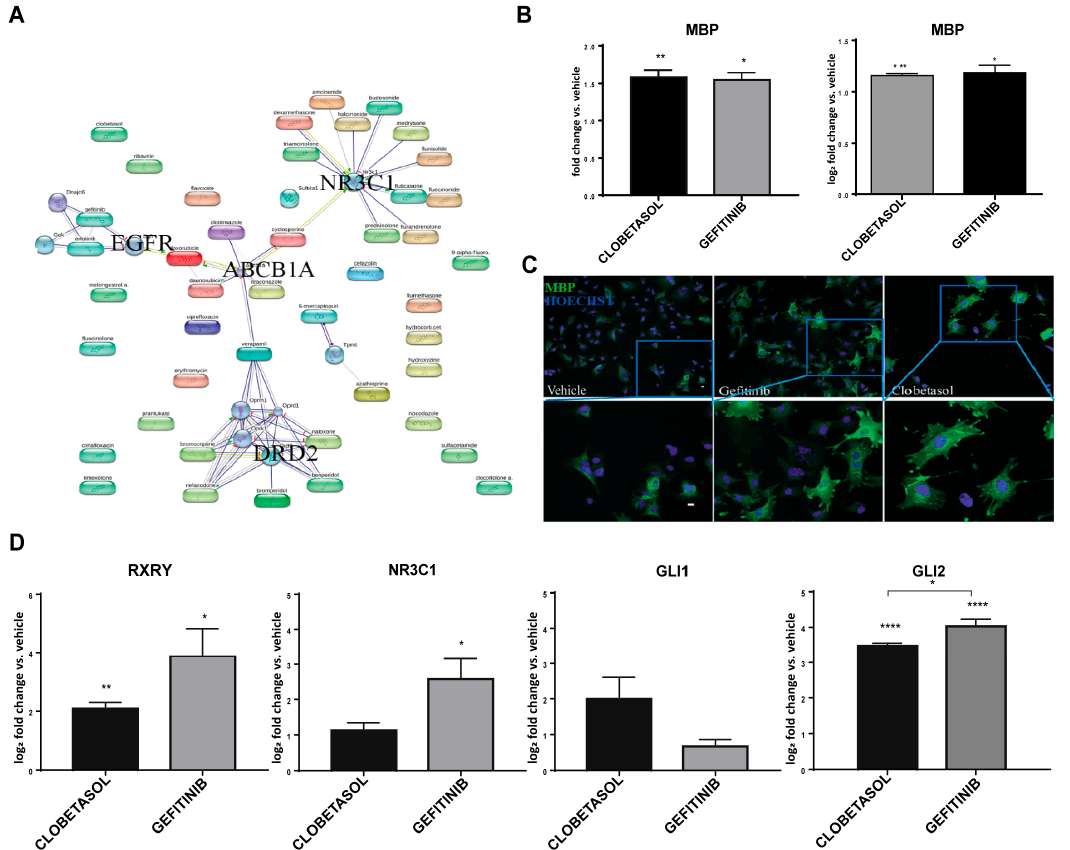
Figure 1. Gefitinib and Clobetasol stimulate MBP, RXR γ and Gli2 expression and Oli-neuM differentiation ( A ) STITCH Confidence view. Chemical-network analysis of drugs promoting MBP expression in OPC cell lines. Thicker lines indicate stronger associations; grey lines: protein-protein interactions. Green: chemical-protein interactions; red: interactions between chemicals. See Table S1 for chemical list and details. ( B ) MBP expression analysis of Oli-neuM treated for 48 h with 5 μ M Clobetasol or 1 μ M Gefitinib. Left panel: immunofluorescence quantitative analysis; Right panel: qPCR expression analyses. Data were normalized to vehicle, and are expressed as mean ± SEM (n = 3) . Statistical significance: two-tailed paired Student’s t test was used for treatment versus vehicle. (C) Representative images of cells quantified in the left panel in B. The bottom images show enlargements of the boxed areas. Scale bar, 10 μ m. (D) qPCR expression analysis of Oli-neuM treated with the indicated drugs. qPCR was performed using oligos indicated in Table S2. Oli-neuM cells were treated as in (B). Data were normalized to an internal control (GAPDH) and plotted as log 2 fold change vs. vehicle, ± SEM using GraphPad Prism (n = 3). Log 2 -fold changes were used to show graphically the positive and negative changes in expression in a symmetrical manner. The level of expression in the control (which equals 1) is represented as 0. Statistical significance: two-tailed Student’s t test was used for treatment versus vehicle, ANOVA one-way with Tukey’s multiple comparison test was used to determine significance among different treatments. * p < 0.05, ** p < 0.01, *** p < 0.001 ¸**** p < 0.0001. Here, we focused on validating the predicted role of the EGFR/ErbB antagonists in OPC maturation up to the stage of axon engagement. Gefitinib is a well-characterized anticancer agent that targets multiple membrane receptors of the EGFR/ErbB family, with a higher affinity for the ATP binding pocket of the EGFR receptor [33,48]. The glucocorticoids Clobetasol, Fluorandrenolide, Halcinonide, Amcinonide and Medrisone are characterized by agonistic activity on the Hedgehog pathway via Smo